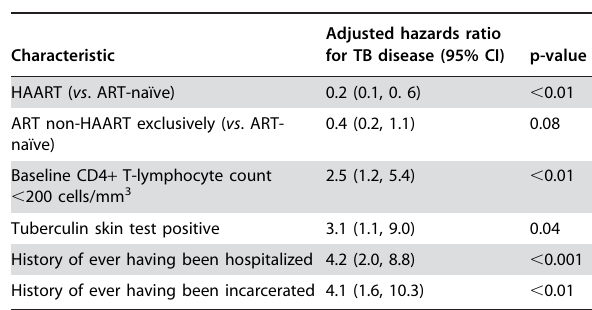
This suggests that those who developed TB may have been more Table 5. Adjusted* hazards ratio of the risk of tuberculosis immunocompromised at baseline than patients remaining TB free; among patients attending public HIV treatment facilities in however, the median baseline absolute CD4 + T-lymphocyte count Brazil (n=463) between January 1, 1995 and December 31, and baseline WHO clinical staging characteristics were not 2001 in a Cox proportional hazards model. .. ... .... ... ... .... ... ... .... ... ... .... ... ... .... ... ... .... ... ... .... . significantly different between the two groups. We cannot exclude the possibility, however, that the study lacked the power to detect Adjusted hazards ratio subtle but clinically important immunological differences among Characteristic for TB disease (95% CI) p-value groups. In areas of high TB prevalence, TB can occur at all levels of CD4 + T-lymphocyte count, though ART-naı¨ve patients who develop TB frequently present with low CD4 + T-lymphocyte counts prior to TB diagnosis [36,37]. Both HAART and non- HAART regimens have been shown to raise CD4 + T-lymphocyte counts and improve the clinical status of HIV-infected patients